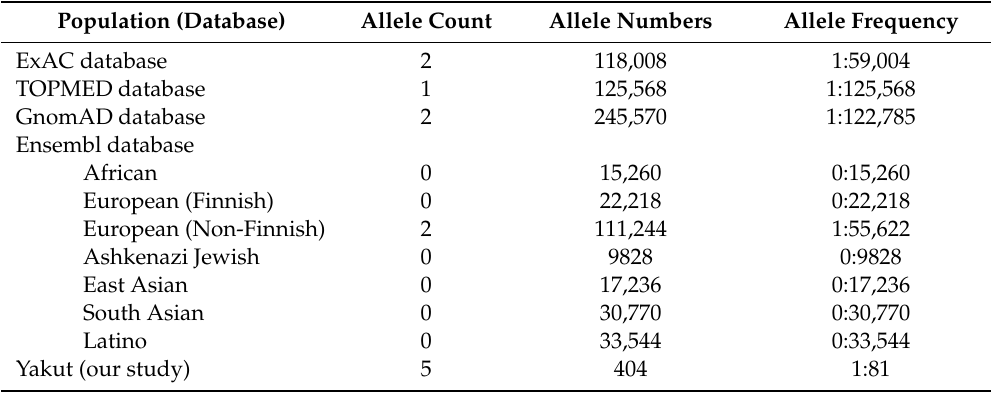
Table 2. Allele frequency of c.1492C > T VPS33A (p.R498W,